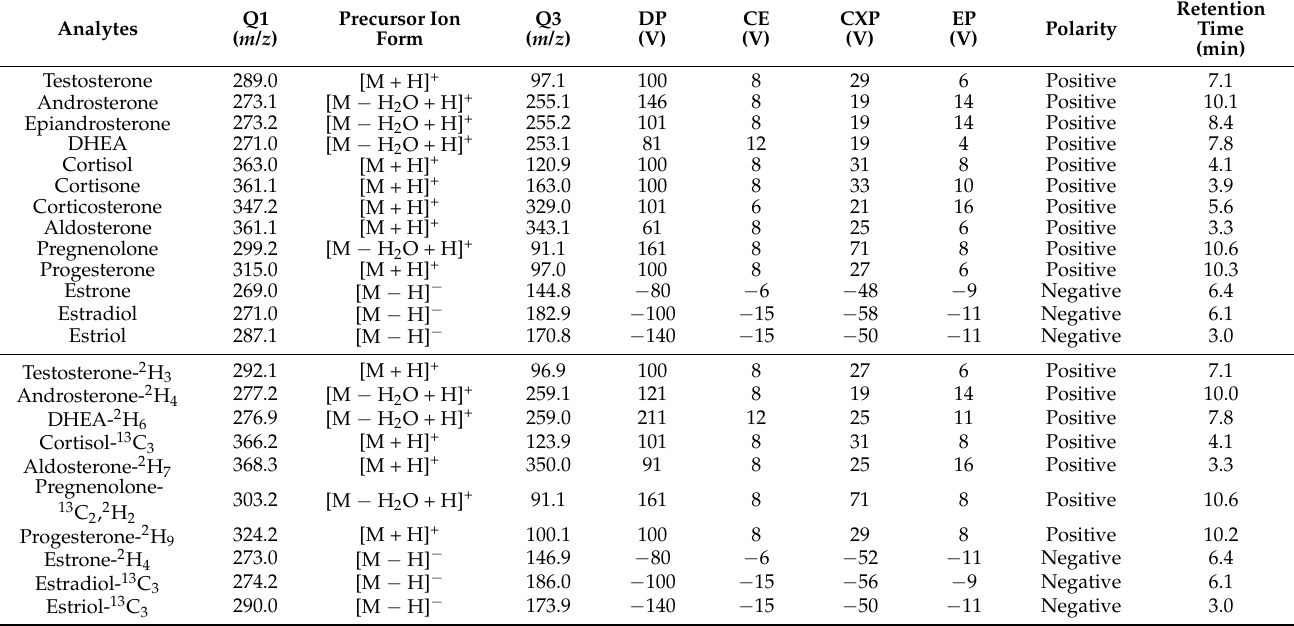
Table 1. SRM parameters and LC retention times for steroid